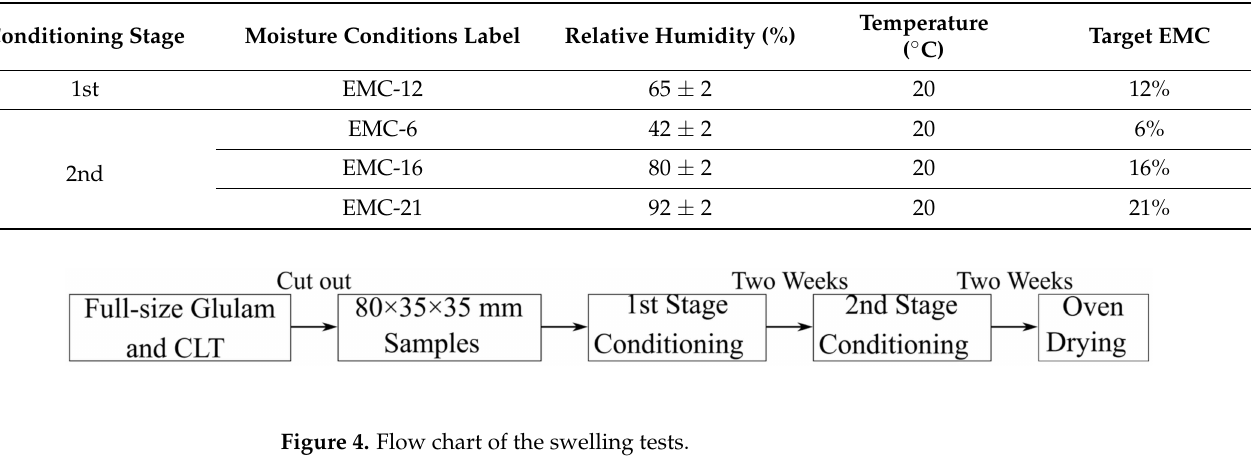
Figure 4. Flow chart of the swelling tests.